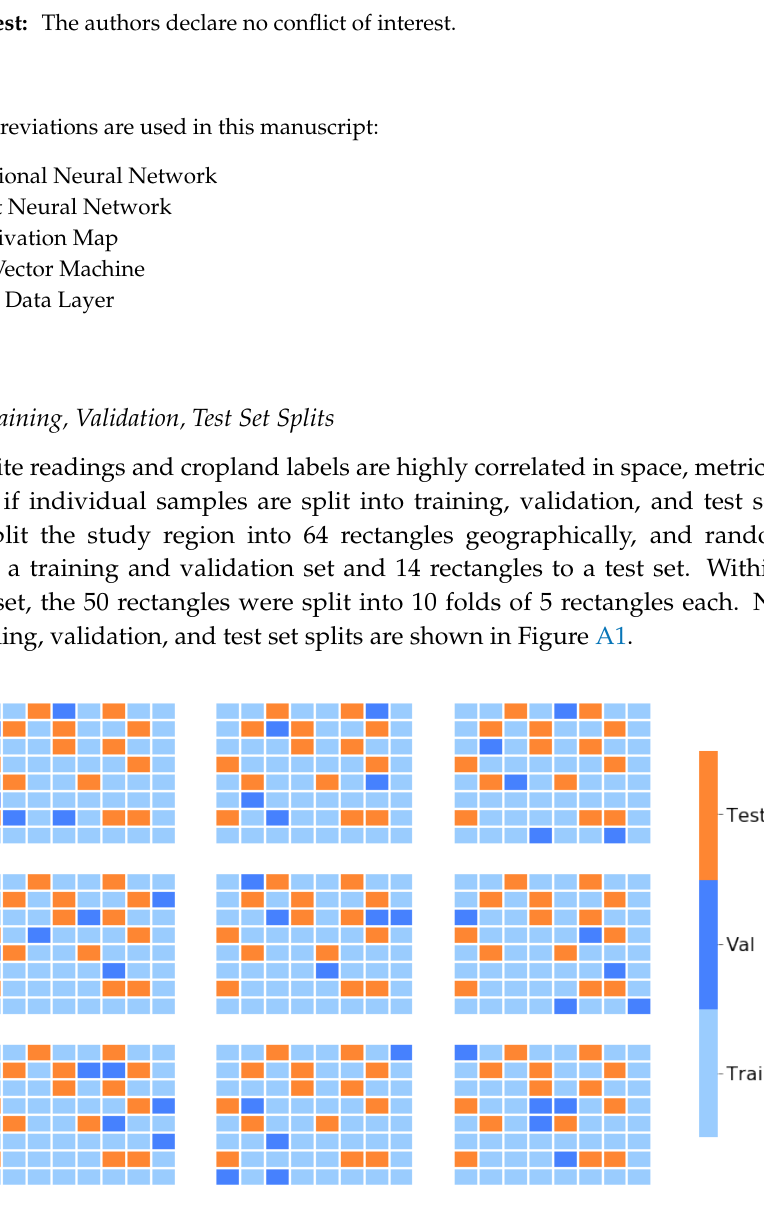
Figure A1. Nine of the ten folds showing training, validation, and test set splits. Folds are defined geographically to reduce performance inflation due to spatial autocorrelation. The first fold is shown in Figure